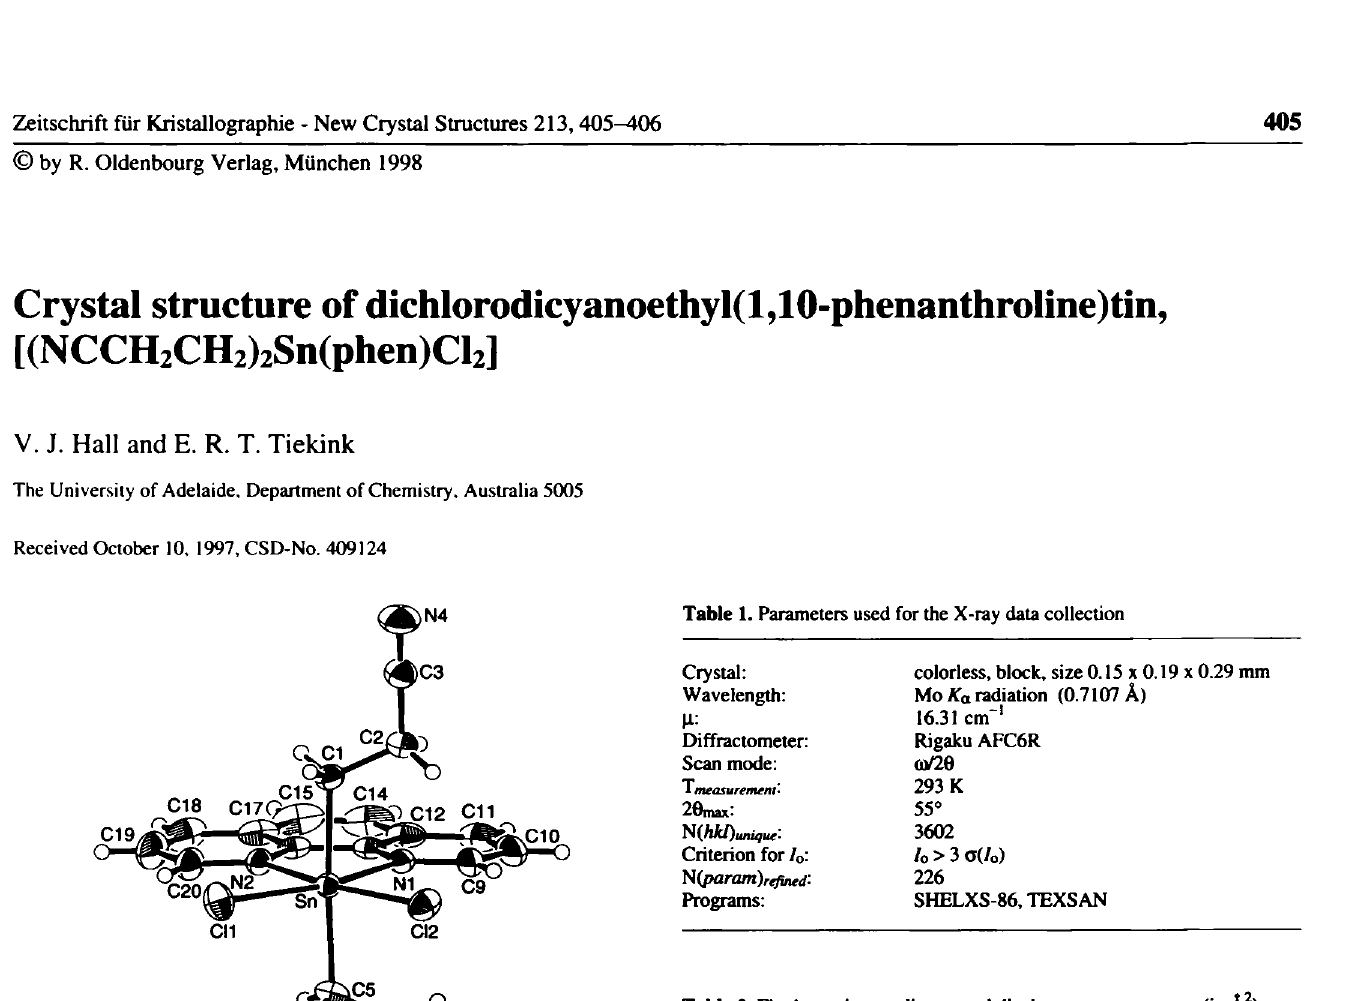
Table 2. Final atomic coordinates and displacement parameters (in